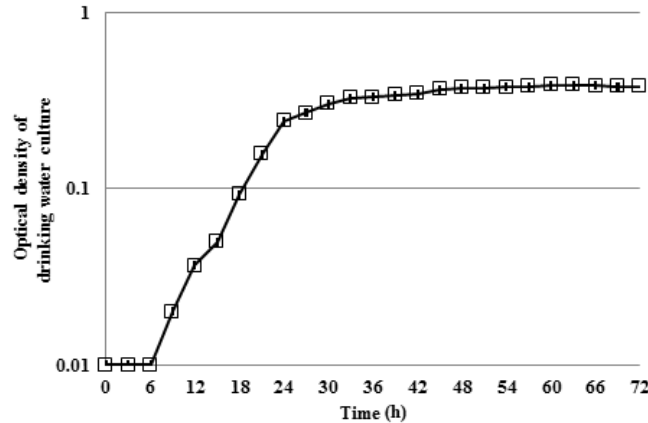
Figure 2. Growth curve of drinking water culture of 1:50 dilution with optical density measured at 595 nm wavelength for 72 h. The error bars represent the standard deviation of the measurements.